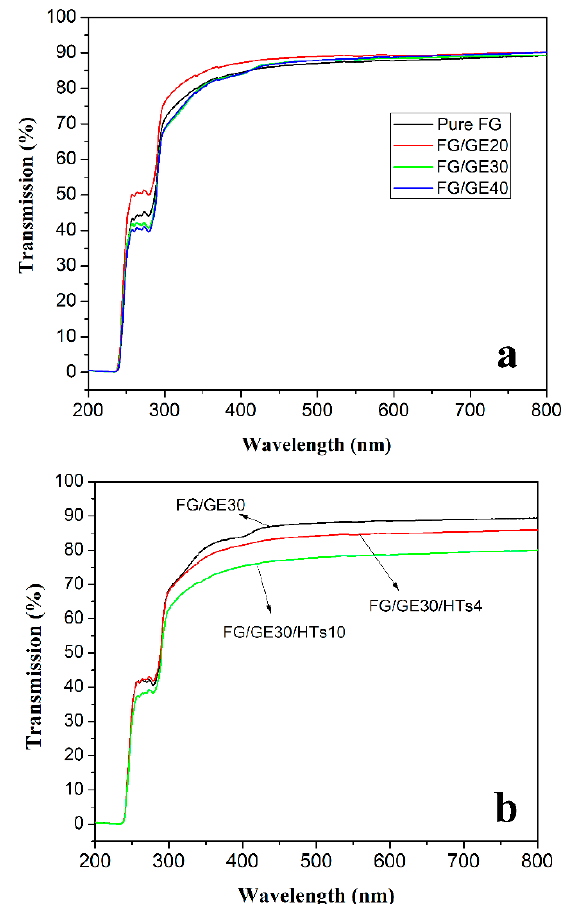
Figure 11. Optical properties of FG/HTs containing 0, 4 and 10 wt % ( a ) and FG/FG30/HTs containing 0, 4 and 10 wt % ( b ).